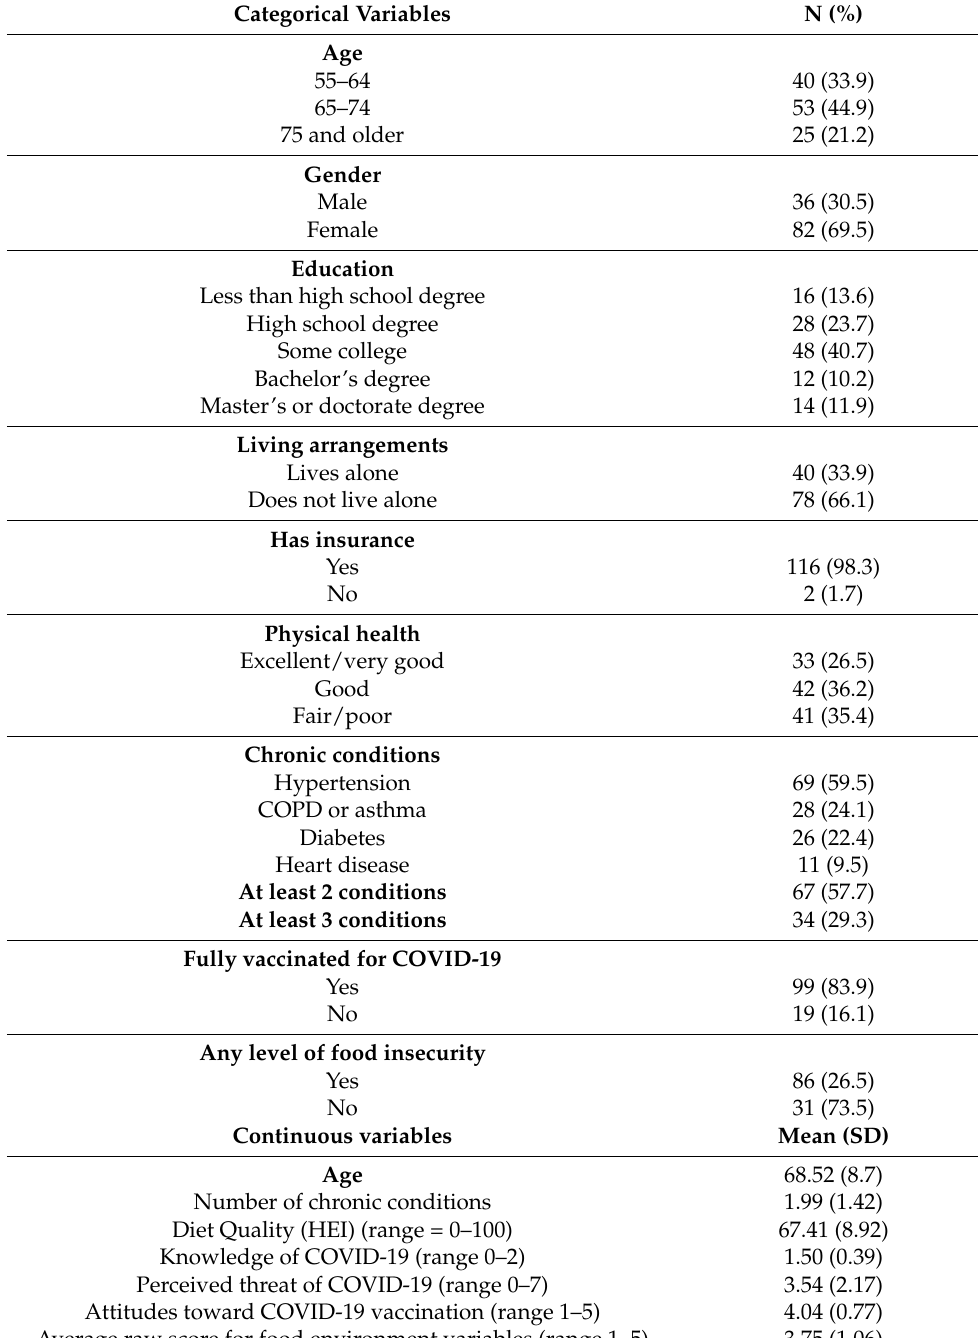
Table 1. Characteristics of study participants (n = 118).